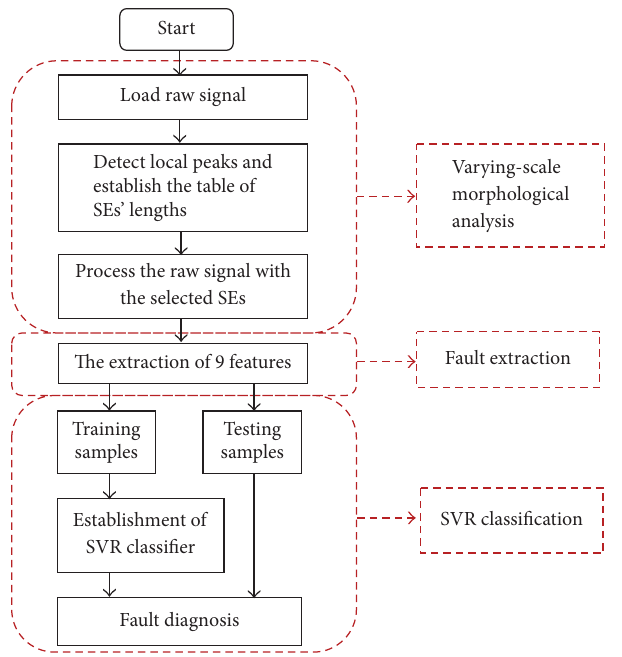
Figure 1: Flowchart of the proposed scheme.